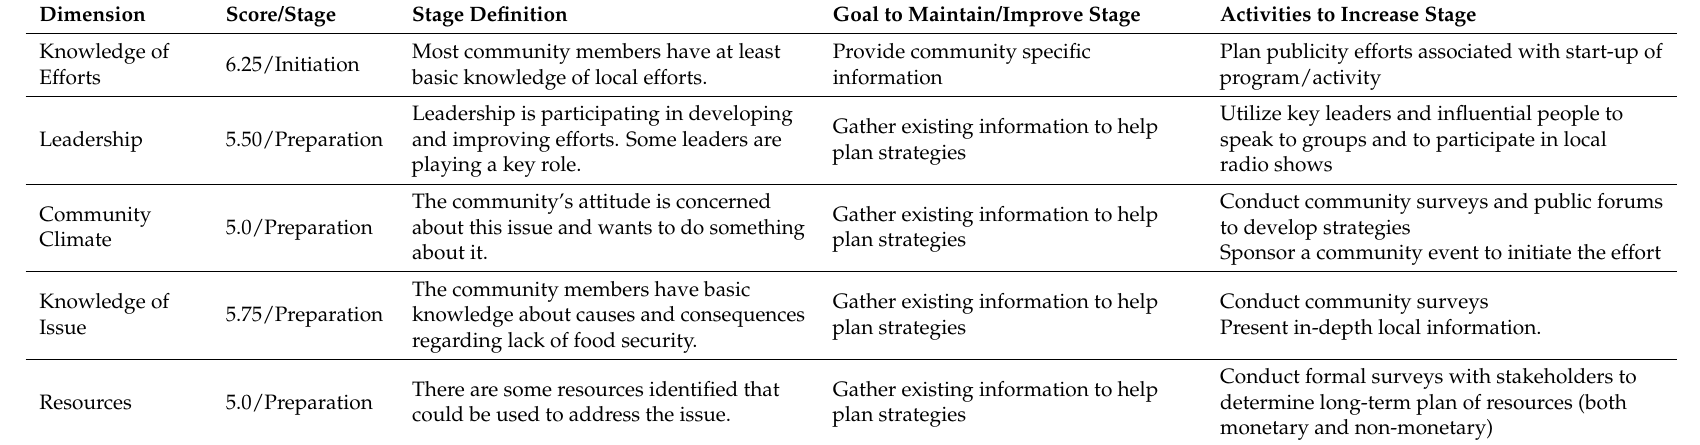
Table 4. Proposed activities to increase community readiness for improving food security according to each dimension (adapted from